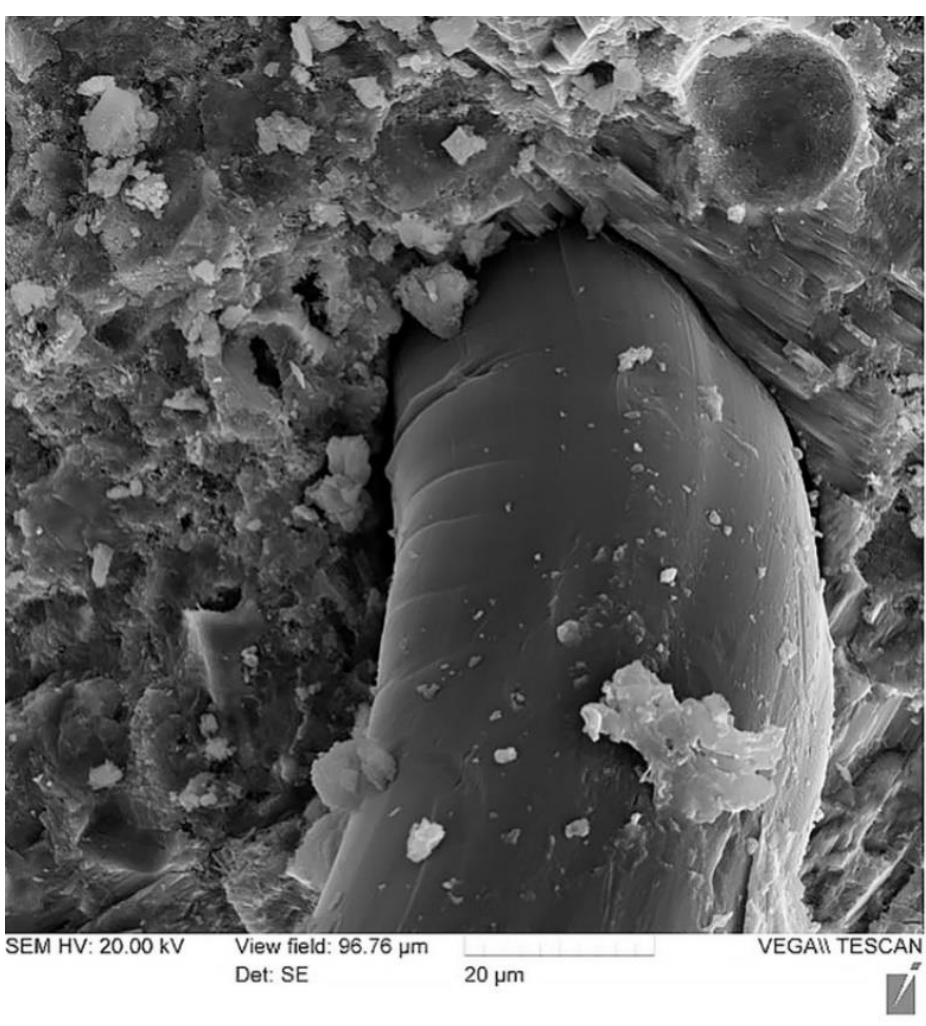
Figure 12. The nature of glass fiber deformation.